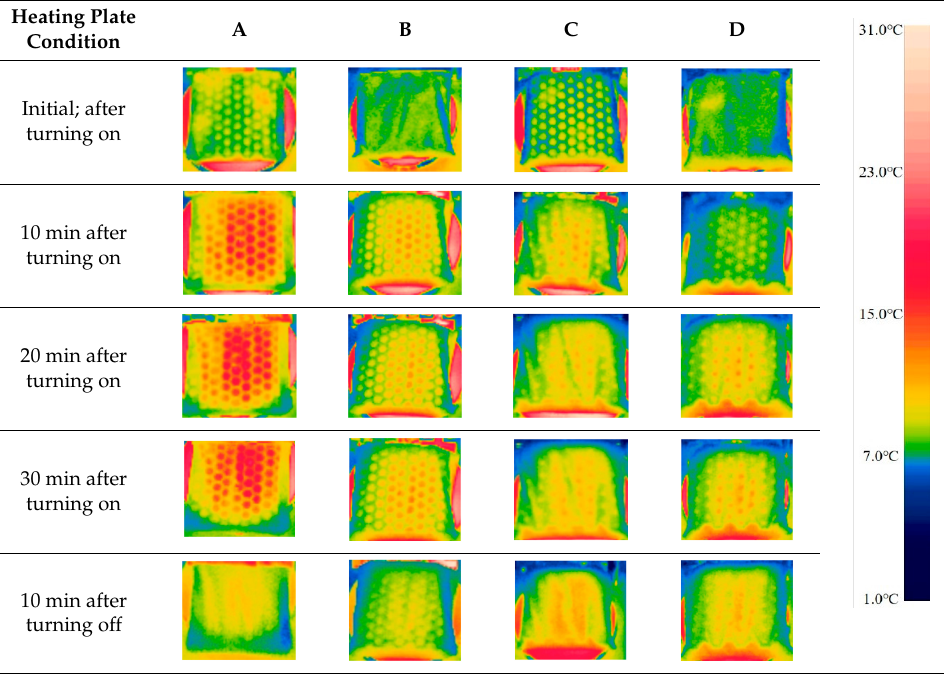
Table 3. Thermogram images of the material